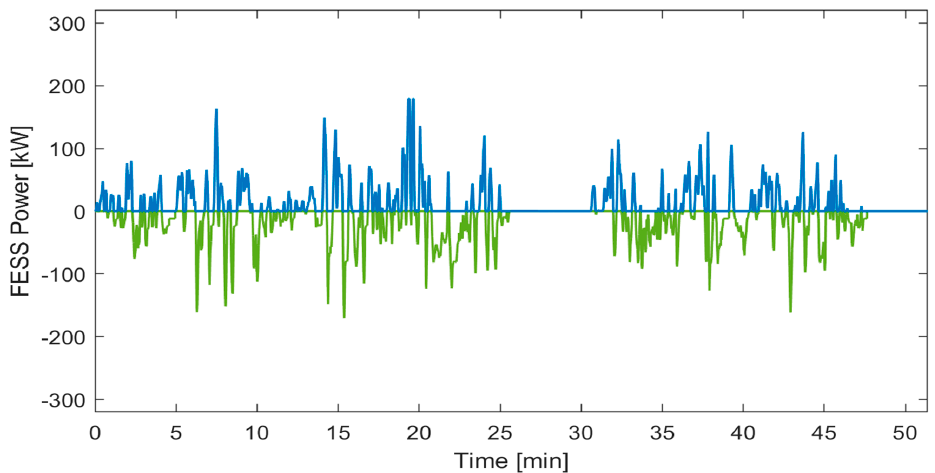
Figure 9. Power profile of the FESS bench.